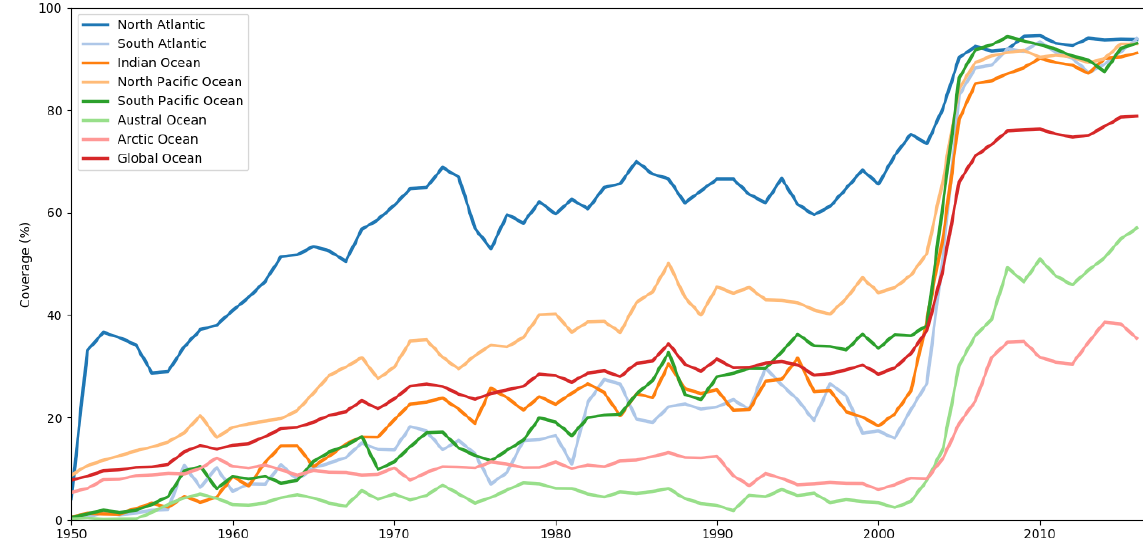
Figure 3. Yearly filling ratio of the 3 ◦ latitude per 3 ◦ longitude gridded field of ocean